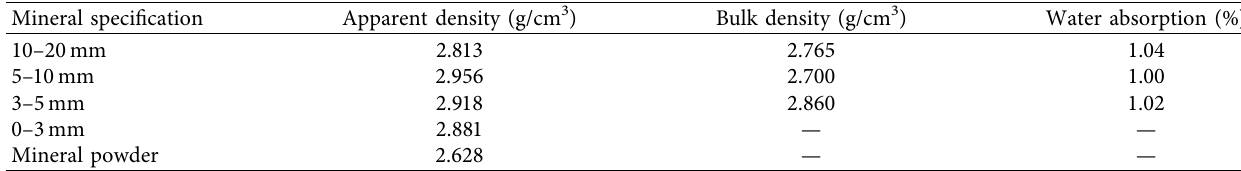
Table 3: Aggregate of BAM test results.